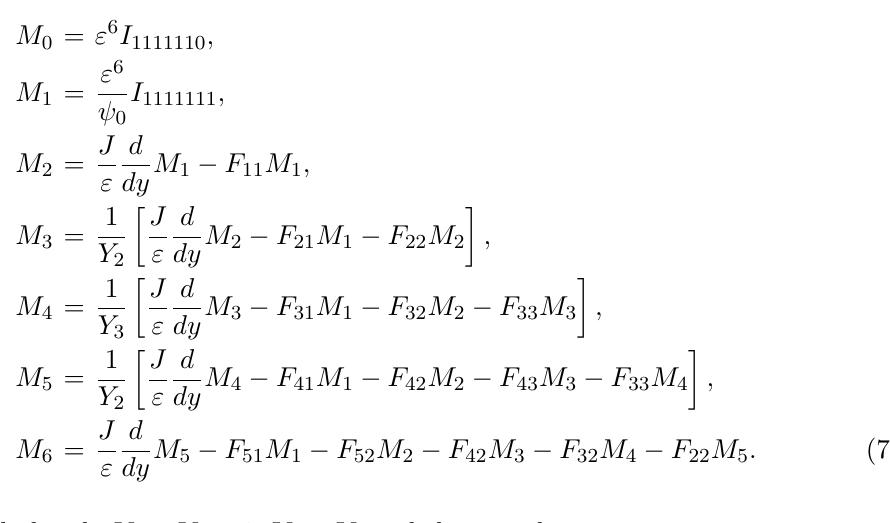
at five loops with numerical results from